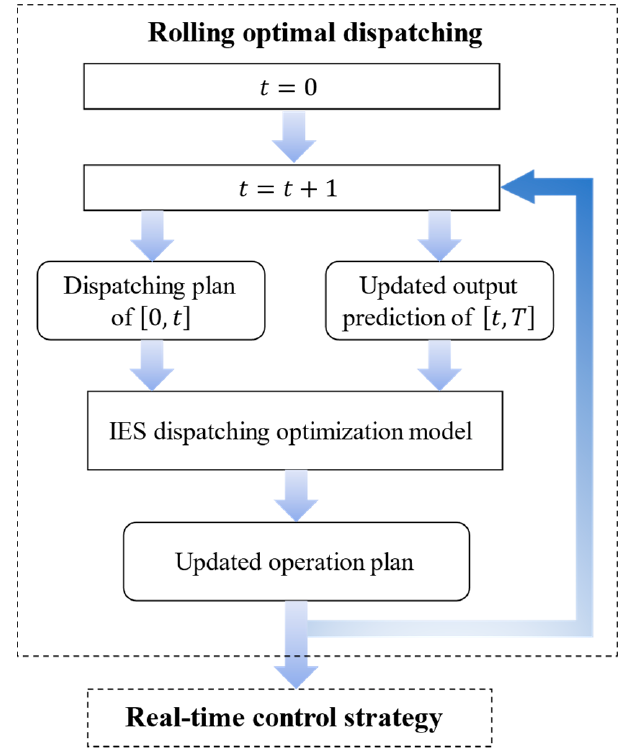
Figure 4. Illustration of rolling optimal dispatching.